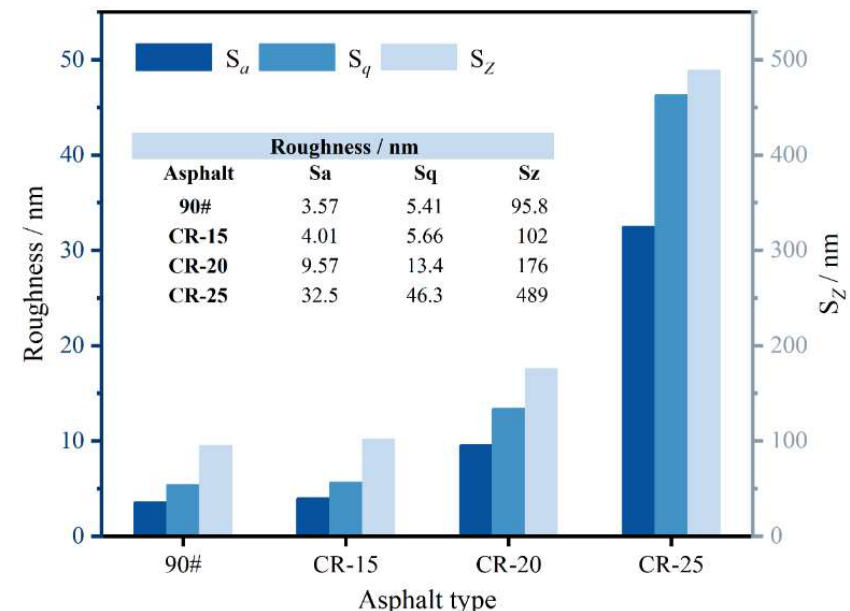
Figure 11. Roughness at different crumb rubber